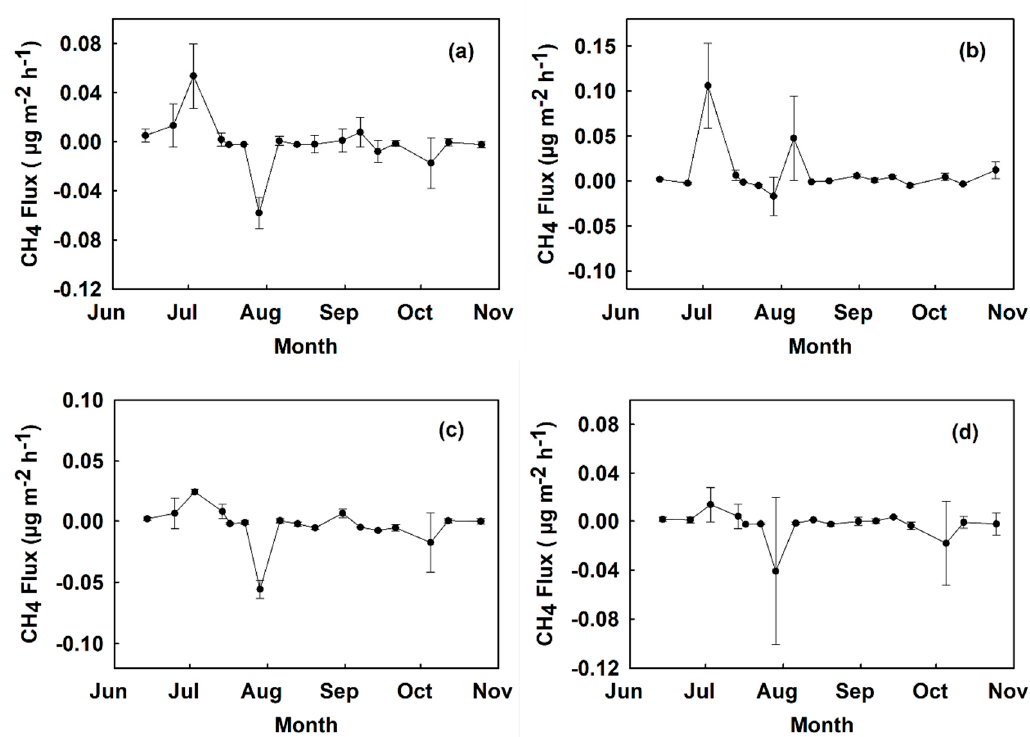
Figure 7. Time series CH 4 fluxes measured from June to October 2018 at site B in μ g CH 4 m − 2 h − 1 by treatment: ( a ) control, ( b ) digestate, ( c ) hydrochar, and ( d ) urea. Values show a mean across two replicated plots with error bars representing the standard error.